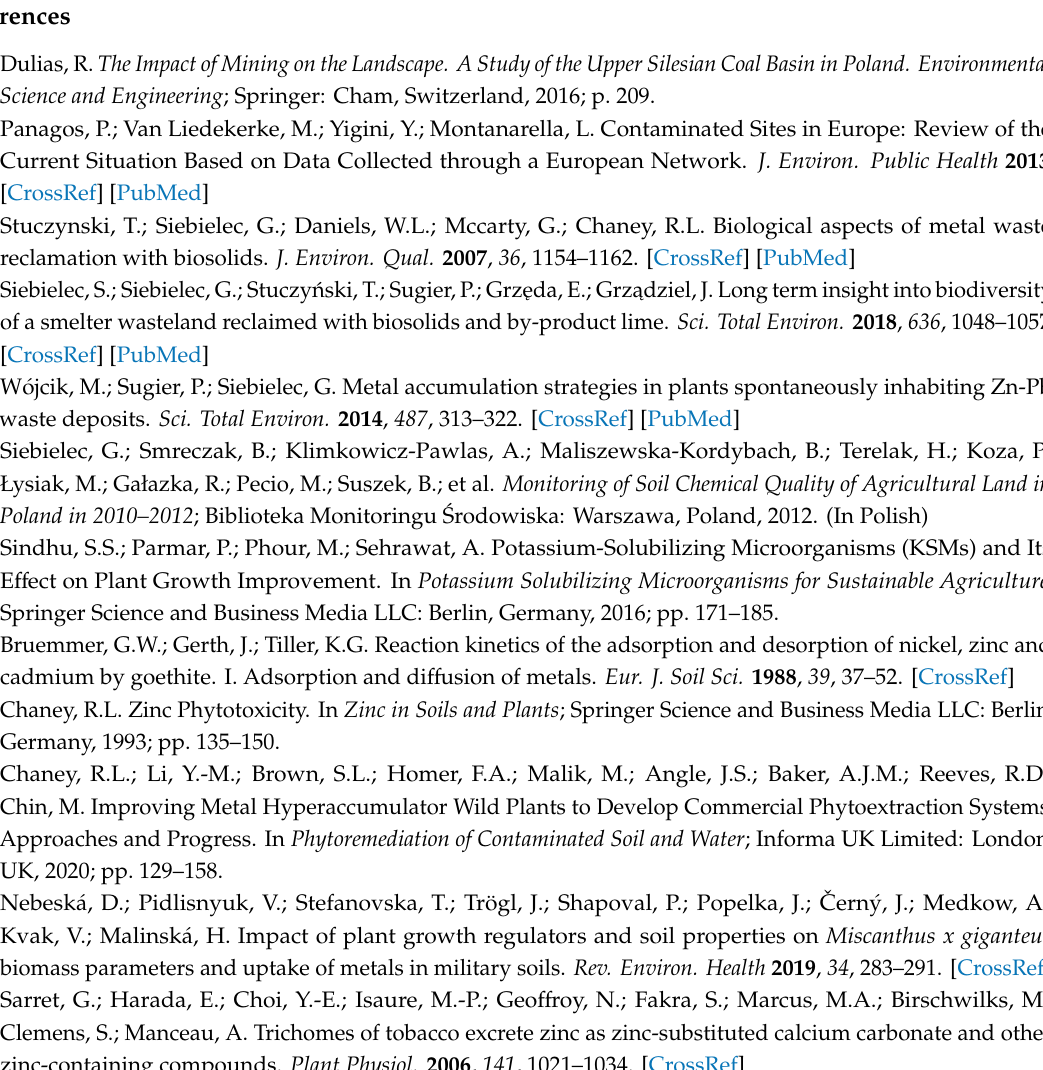
Supplementary Materials: The following are available online. Table S1: CaCl 2 -extractable metal contents in FW and SW soils, Table S2: Correlation coe ffi cients for relationships between soil chemical variables and microbial abundance and activity, Table S3: Results of PCA based on contents of extractable trace elements and intensity of C substrate utilization, Table S4: Correlation coe ffi cients for relationships between metabolic activity parameters and extractable forms of trace elements, Figure S1: Heat maps of the metabolic profile of microorganisms based on utilisation of the 31 C sources using the EcoPlate method after 144 h incubation, Figure S2: The border between the smelter waste pile (Dolki) and the arable land (cabbage field)—year